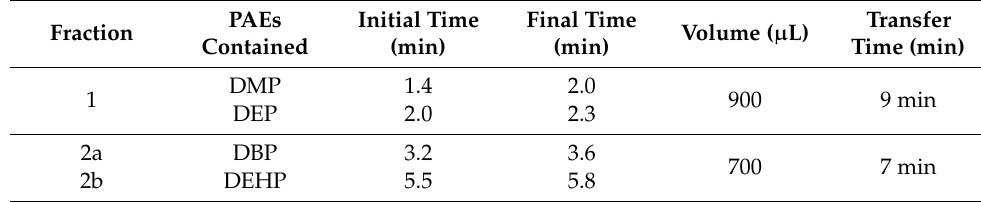
Table 1. Characteristics of LC